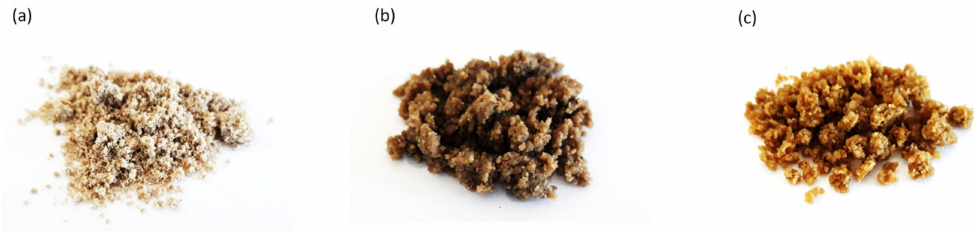
Figure 1. Hemp shives (HS) fillers used as reinforcing fillers: ( a ) non-treated hemp shives (HS), ( b ) hemp shives impregnated with sunflower oil (HS / SO), and ( c ) hemp shives impregnated with tung oil (HS / TO).